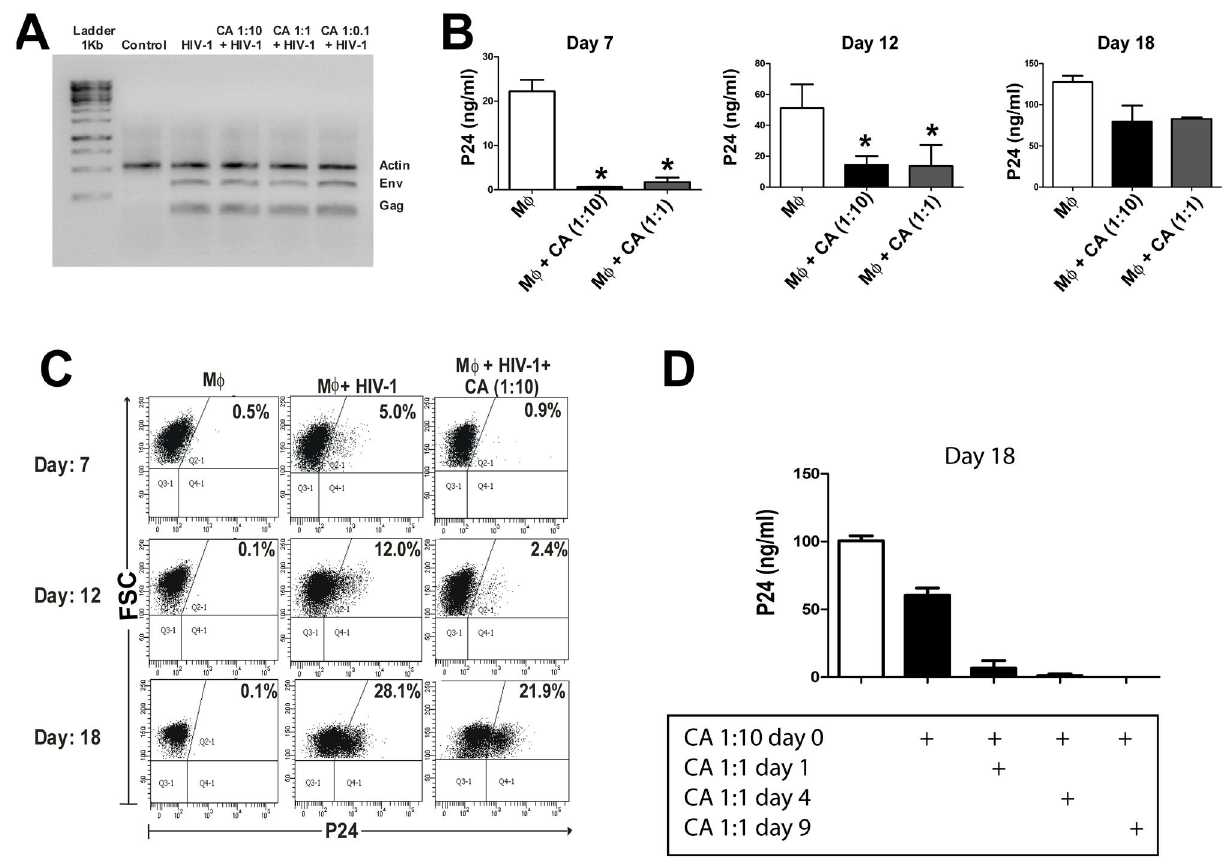
Figure 6. Candida albicans promotes and sustains a latent-like HIV-1 infection in macrophages. ( A ) Macrophages (5x10 5 /0.5 ml) were cultured with HIV-1 (50 ng p24/ml) for 2 h at different macrophage: CA ratios. Then, cells were washed BaL thoroughly and cultured for an additional period of 18 h. PCR amplification of HIV-1 DNA (env, and gag) was performed in cell lysates and β-actin was evaluated as a control. A representative experiment (n=3) is shown. ( B and C ) Macrophages (5x10 5 /0.5 ml) were cultured for 2 h with HIV-1 (50 ng p24/ml) in the absence or presence of CA (macrophage: CA ratios of 1:10 and 1:1). Then, BaL cells were washed and the production of HIV-1 was evaluated at 7, 12, and 18 days post-infection in cell supernatants by p24 ELISA ( B ) or by intracellular staining of p24 antigen and flow cytometry ( C ). ( B ) Graph bars represent the arithmetic means ± SEM of 4 experiments carried out in duplicate. * p<0.05 vs M ϕ . ( C ) Dot plots from a representative experiment (n=3) are shown. ( D ) Macrophages (5x10 5 /0.5 ml) were cultured with HIV-1 (50 ng p24/ml) for 2 h in the absence or presence of CA (macrophage: CA BaL ratio of 1:10). Then, cells were washed thoroughly and incubated in culture medium. At days 1, 4, or 9 after the initial challenge by HIV-1, cell cultures were supplemented with additional amounts of CA (macrophage: CA ratio of 1:1), and the production of HIV-1 was evaluated in all cases at day 18 post-infection in cell supernatants by ELISA. Graph bars represent the arithmetic means ± SEM of 5 experiments. * p<0.05 vs M ϕ cultured without CA (white bar) and ** p<0.05 vs M ϕ + CA (day